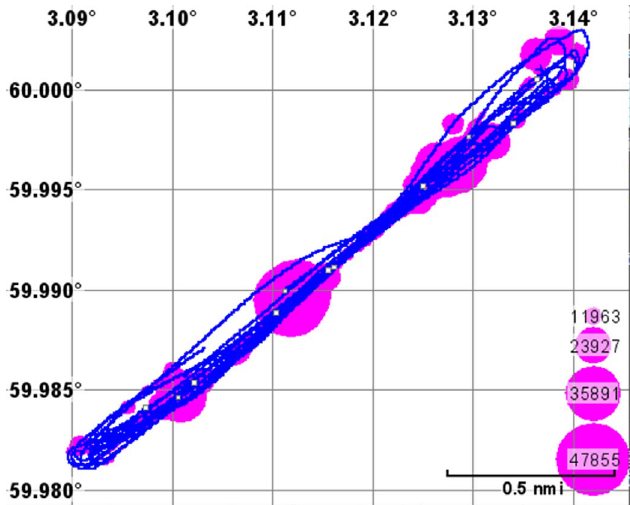
Figure 1. Cruise track (blue curves) for the acoustic survey and observed fi sh schools (purple blobs). The axes indicate longitude and latitude in decimal degrees. The values in the legend are the nautical area scattering coef fi cient s A [nmi (cid:3) 1 ] [33]. Note that the cruise tracks do not overlap completely. Each school could be crossed straight over in one leg and on a side in the next, even if the schools did not move. Table 1. Parameters used in numerical calculations for comparison with the in-situ survey measurements: Nominal power P nom , source condition pressure amplitude | P s |, effective source radius a , temperature T , salinity S , depth d , density q 0 , pH, ambient sound speed c 0 , and coef fi cient of nonlinearity b .